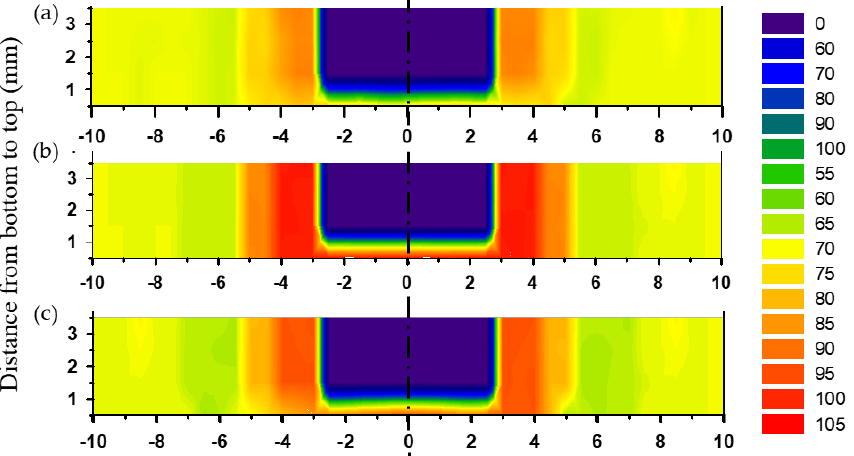
Figure 7. Hardness-colored contour maps of the FSSWed AA5052-H32 joints produced at 500 rpm and various dwell times of ( a ) 1 s, ( b ) 2 s, and ( c ) 3 s.